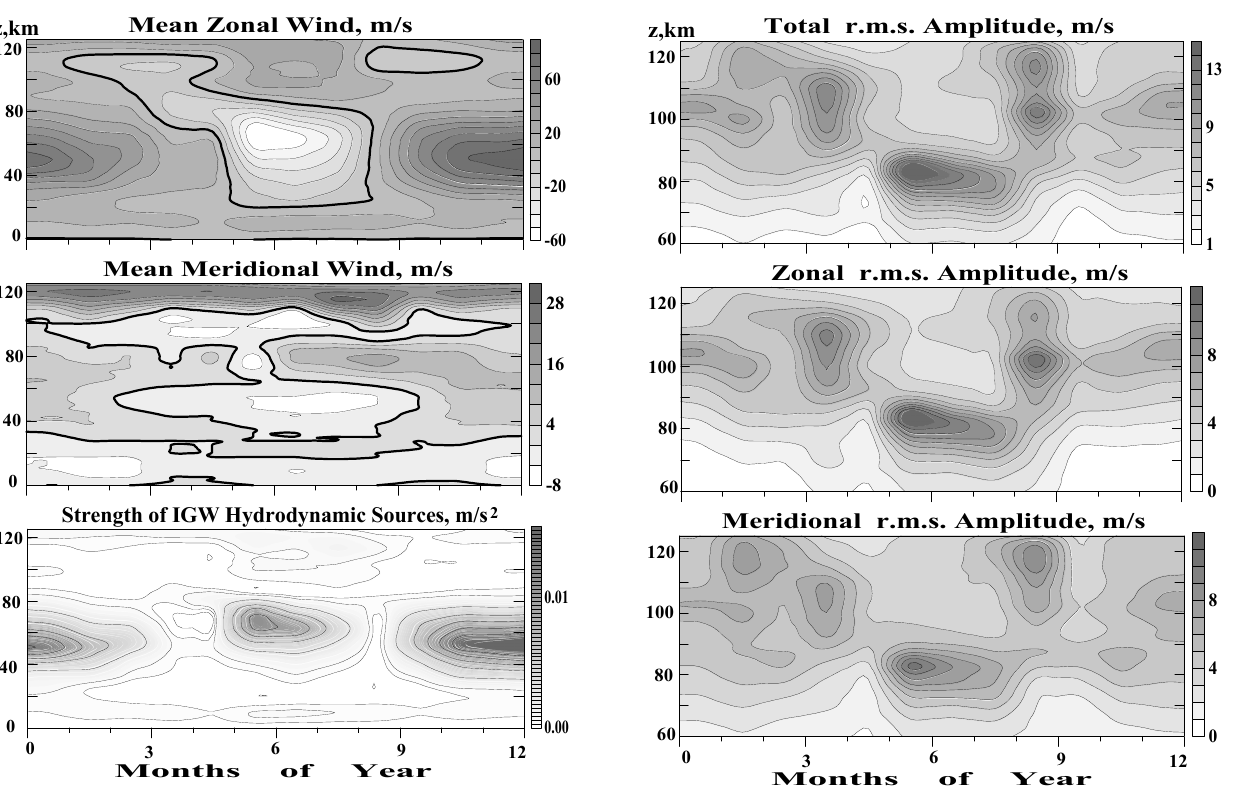
Fig. 5. Same as Fig. 3, but for IGW sources located below altitude Fig. 5. “Gavrilov and Jacobi, A study of seasonal…”